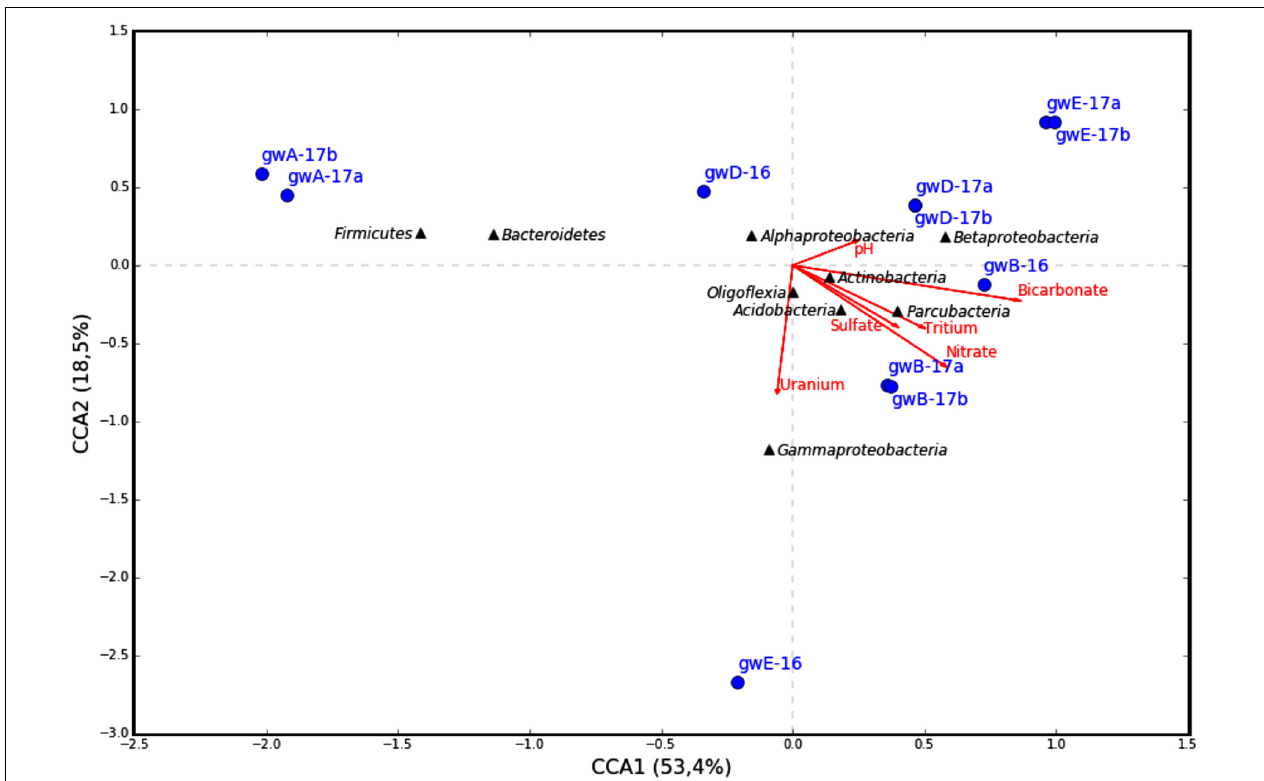
FIGURE 6 | Canonical correspondence analysis (CCA) showing the correlation between bacterial diversity at phylum or class level in the 16S rRNA gene libraries of the microorganisms from groundwater and geochemical parameters of the groundwater